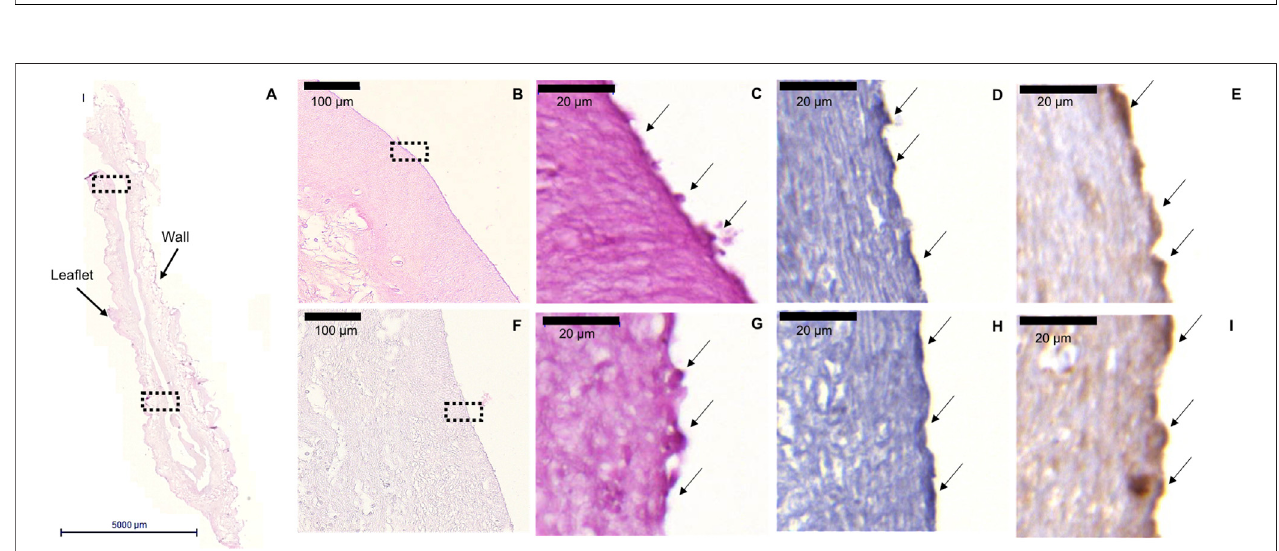
FIGURE 7 | ECFCs retention after TESV crimping procedure. Representative images of the H&E, CD31, and vWF stainings performed on the cross section of the valve. (A) : H&E staining shows general morphology of TESV (5000 µm scale bar). (B,F) : ×20 magni fi cation pictures of the H&E staining of the upper (B) and lower (F) lea fl etofthevalveshowingthepresenceofECFCsonthesurface(100 µmscalebars). (C,G) :×100magni fi cationpicturesofH&Estainingoftheupper (C) andlower (G) lea fl et marked by the dotted rectangles in panels (B,F) respectively (20 µm scale bars). (D,H) : ×100 magni fi cation pictures of CD31 staining shows ECFCs presence in the upper (D) and lower (H) lea fl et (20 µm scale bars). (E,I) : ×100 magni fi cation pictures of vWF staining expressed by ECFCs in the upper (E) and lower (I) lea fl et (20 µm scale bars).